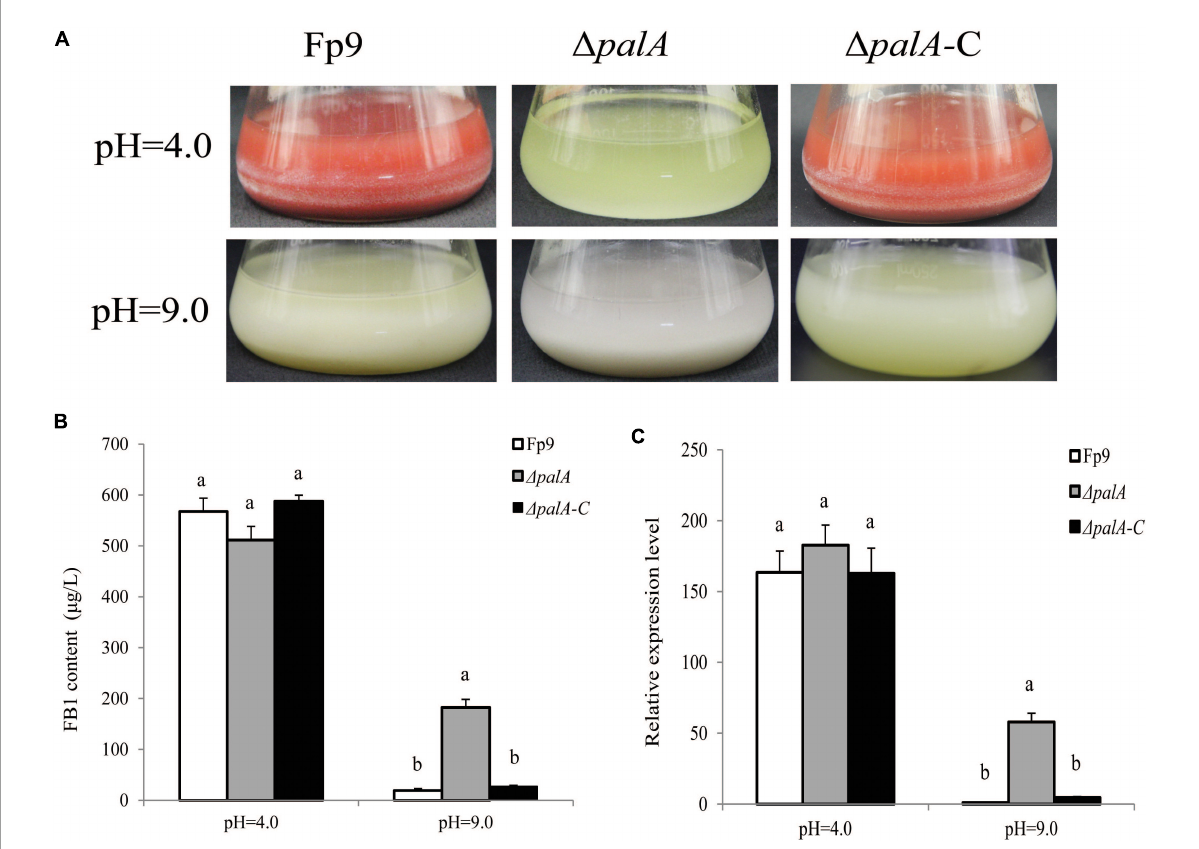
FIGURE7 FB1 production activated by PalA in pH-dependent manner. (A) Seven-day-old DL cultures of (cid:49) palA mutant. (B) FB1 production of (cid:49) palA grown in YEPD media for 72 h before switching to DL cultures for 7 days at pH = 4.0 and pH = 9.0, respectively. Different letters on bars indicated a significant difference ( p < 0.05) with three biological replicates. (C) The expression levels of FUM1 gene of (cid:49) palA grown in YEPD media for 72 h before switching to DL cultures for 48 h at pH = 4.0 and pH = 9.0,